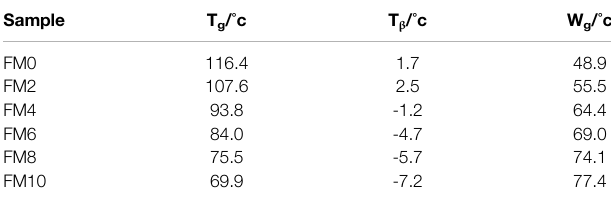
TABLE 2 | T g , T β , and W g of PCTFE and PTCFE/FCO blends measured by